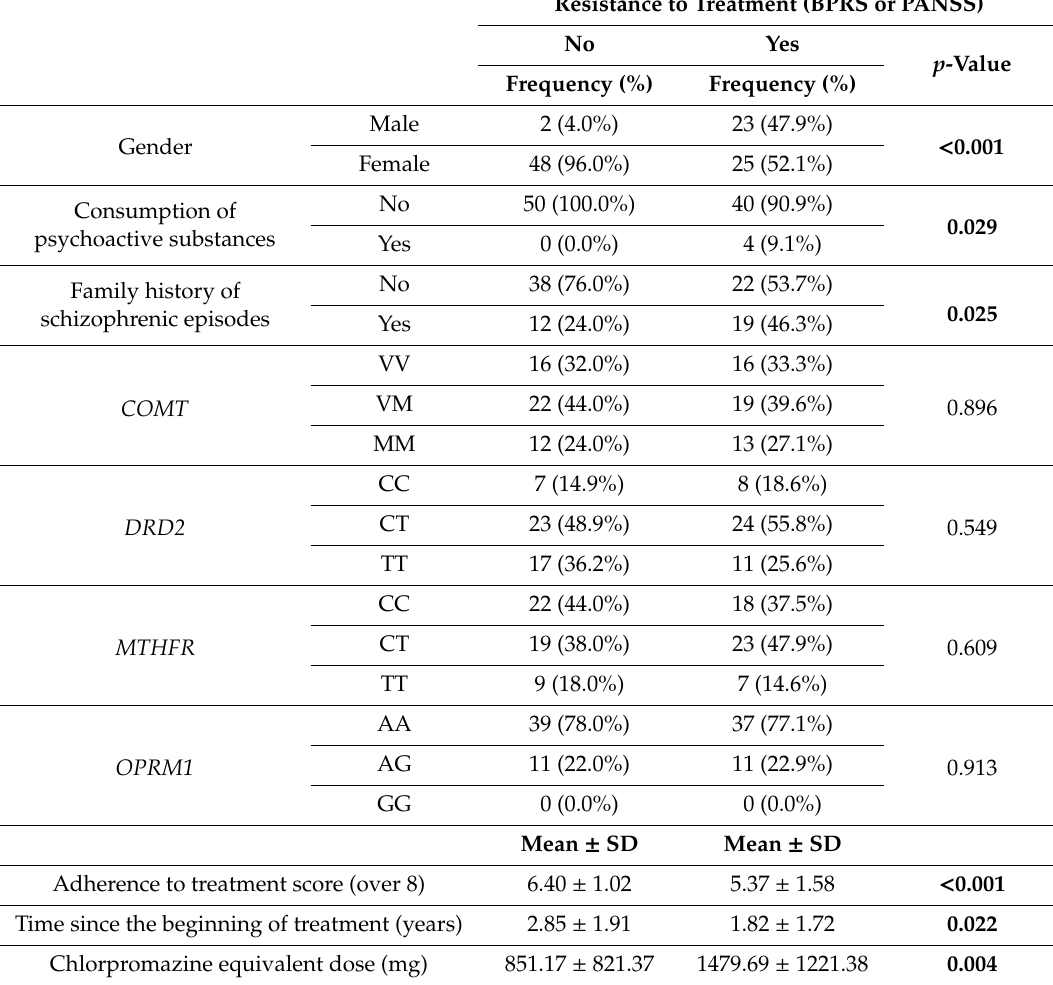
Table 5. Bivariate analysis taking the resistance to treatment, evaluated by the BPRS or PANSS scales, as the dependent